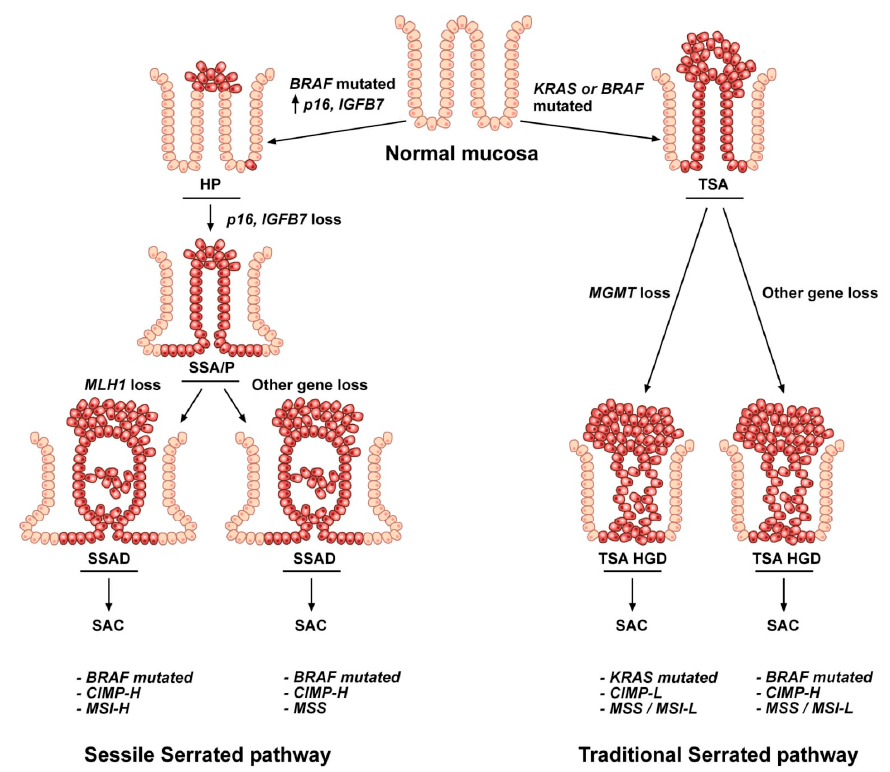
Figure 3. Representation of the two serrated pathways. The sequence leading to serrated Colorectal cancer (CRC) can occur in two different molecular pathways, the sessile and the traditional serrated routes. The tumorigenic process involves progressive accumulation of specific genetic and epigenetic hits affecting normal colon epithelial cells. In the sessile serrated pathway, the transformation of the normal mucosa begins with BRAF mutations, followed by p16 and IGFBP7 promoter hypermethylation and the consequent progression toward serrated adenocarcinoma, mainly through MLH1 epigenetic alterations. In contrast, the traditional serrated pathway involves KRAS or BRAF mutations in normal colon cells which, together with MGMT or other gene methylation alterations, malignantly evolve toward traditional serrated adenoma (TSA) high-grade dysplasia and serrated adenocarcinoma (SAC).